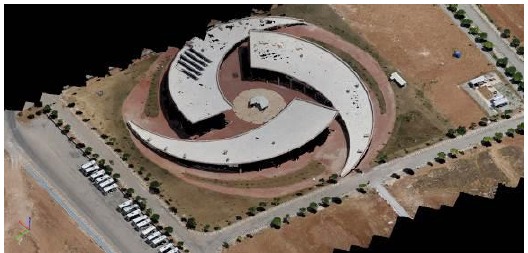
Figure 5. Point cloud of GAP YENEV derived from multi-copter